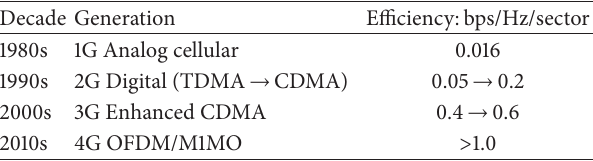
Table 1: Cellular system: 1G to 4G.